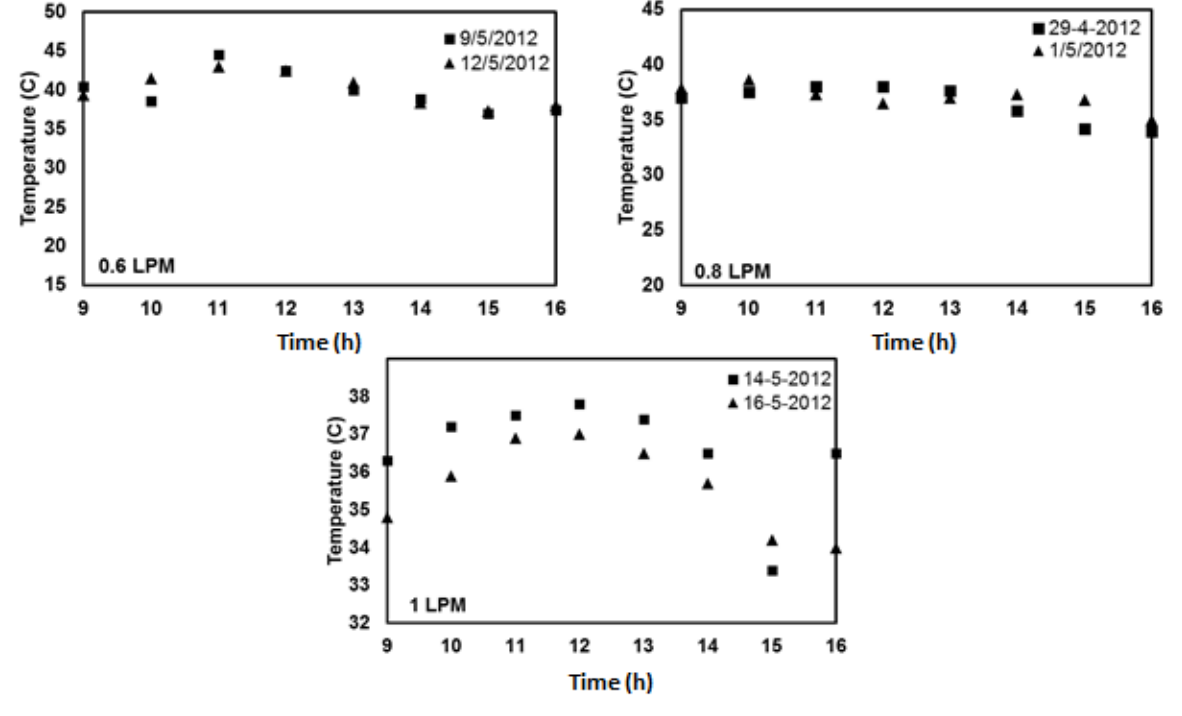
Figure 18. Outlet fluid